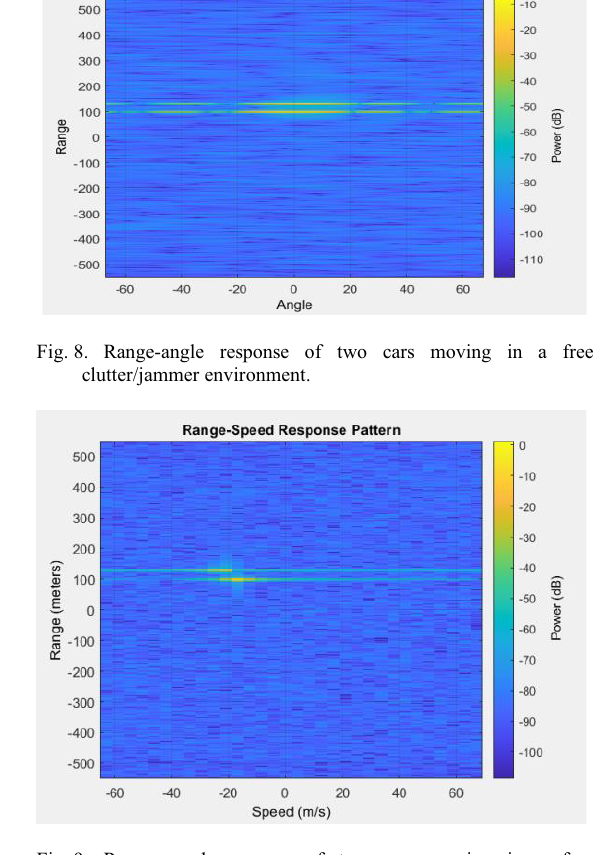
Fig. 9. Range-speed response of two cars moving in a free clutter/jammer